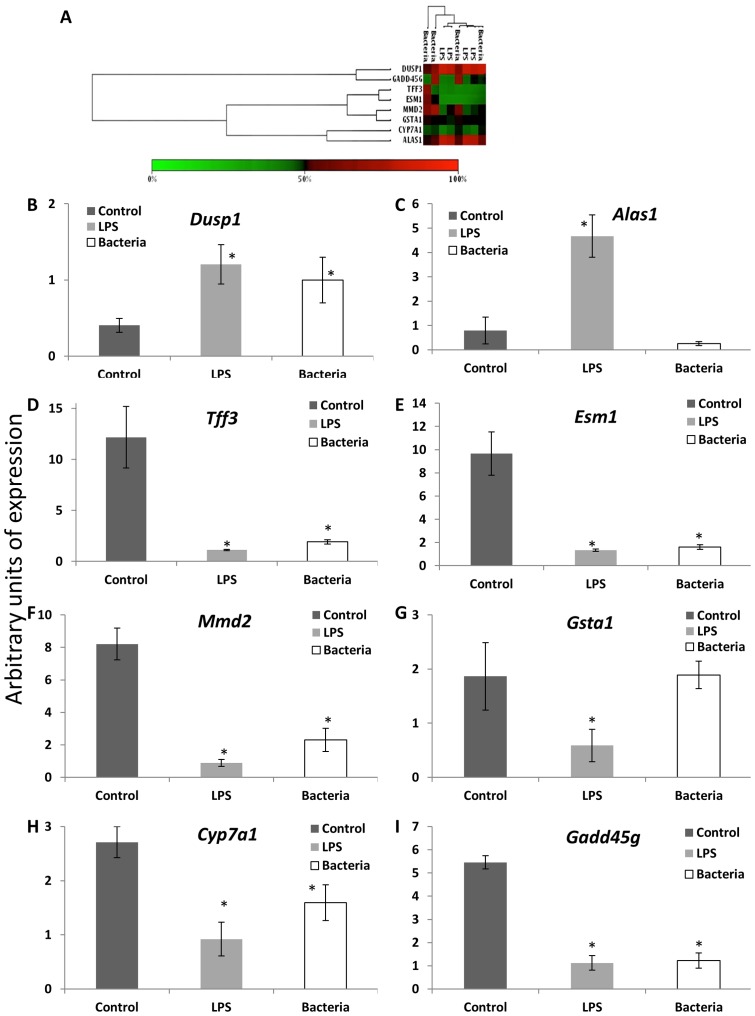
Exposure to LPS and Bacteria alters mRNA levels in mouse livers.A. Clustering of differential expression of genes with the use of control as a standard. Red denotes high expression levels, whereas green denotes low expression levels. RTPCR gene expression analysis of Dusp1 (B), Alas1 (C), Tff3 (D), Esm1 (E), Mmd2 (F), Gsta1 (G), Cyp7A1 (H), Gadd45g (I). Bars show normalized expression levels (average from three reactions, with SD) of aforementioned genes in control and two groups exposed for 2 weeks, whole heat-killed bacteria and LPS groups. Normalization was conducted with Actin transcription levels. Asterisks indicate significant difference (p<0.05).